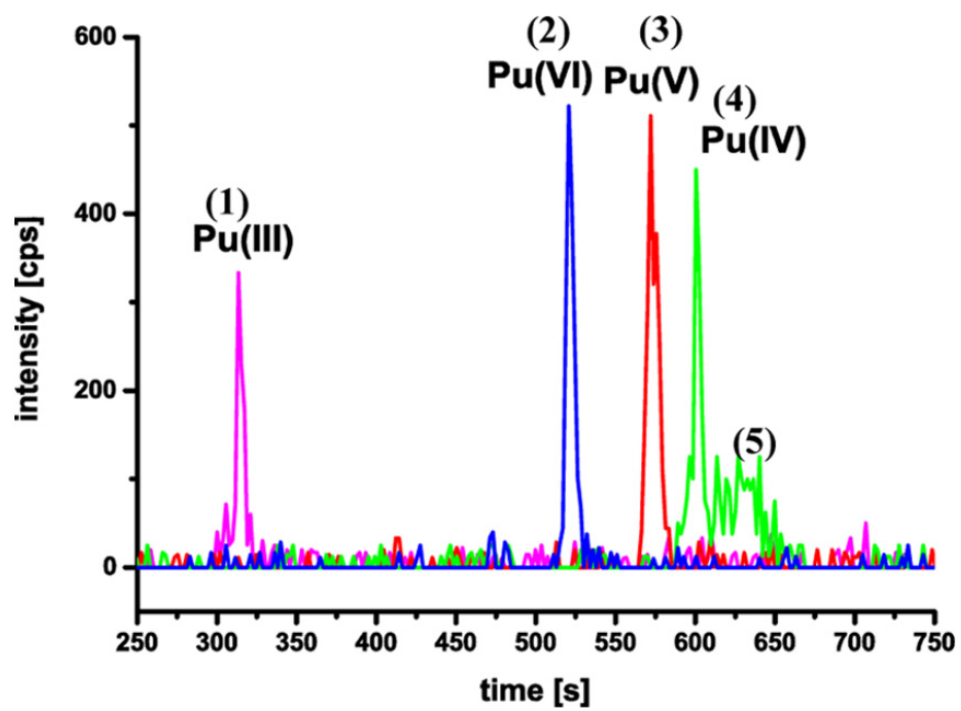
Figure 8. Combined electropherogram of 242 Pu reference solutions in 1M HClO 4 : peak (1) Pu(III), peak (2) Pu(VI), peak (3) Pu(V), peak (4) Pu(IV), and peak (5) Pu(IV) polyspecies ( t > 600 s); ([ 242 Pu] = 2.1 × 10 − 10 M; hydrodynamic injection: 10 s/2 psi; voltage: 30 kV; BGE: 1 M HAc; pH = 2.4). Reprinted with permission from ref. [50]. Copyright 2021 Amrican Chemical Society.